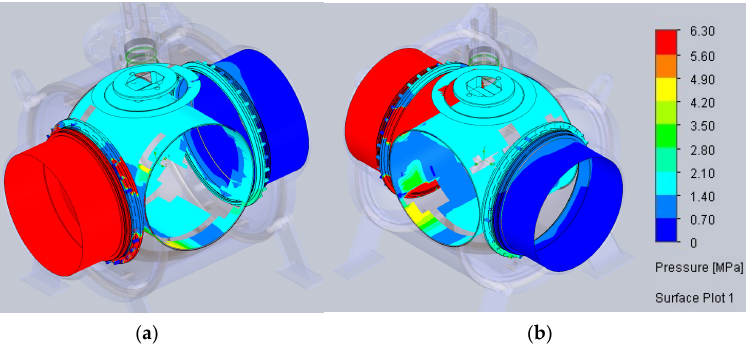
Figure 13. Pressure contour for the fully closed valve: ( a ) upstream view; ( b ) downstream view.